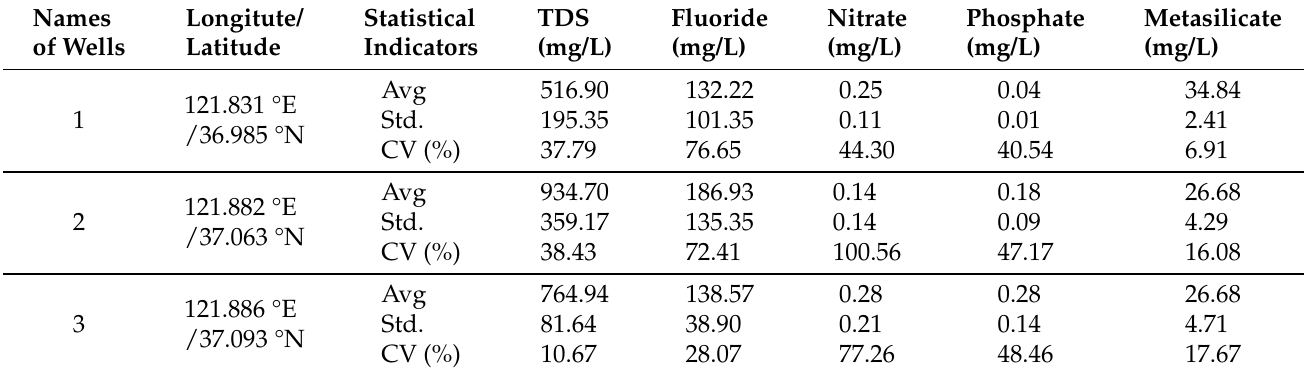
Abbreviations used in this table include: Avg: average; Std.: standard deviation; CV: coefficient of variation (%).